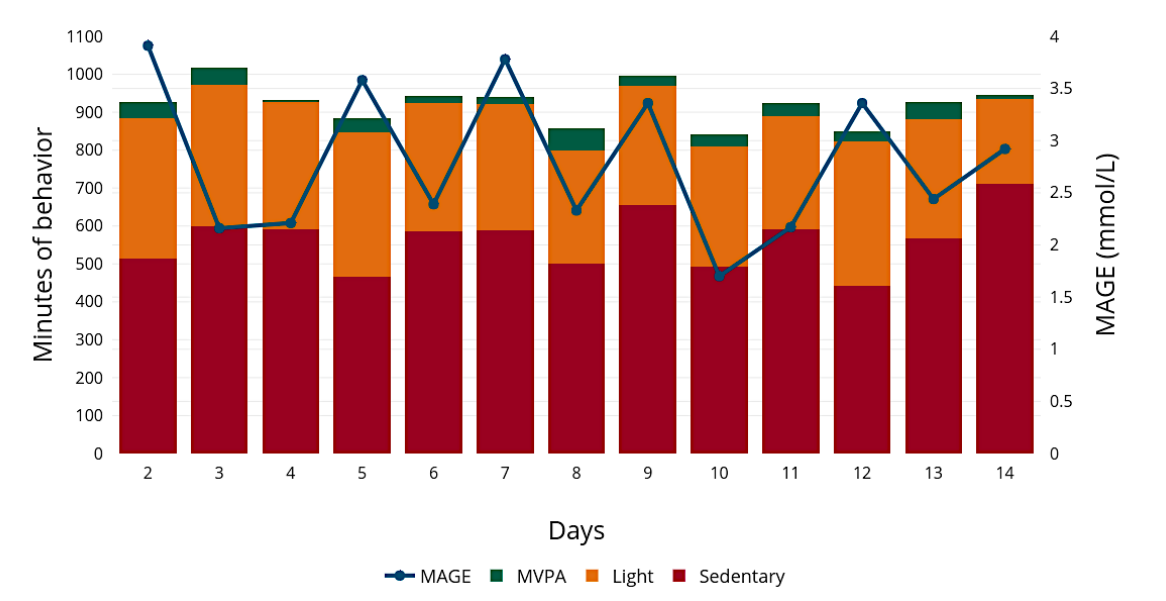
Figure 1. Minutes of sedentary, light, moderate to vigorous physical activity (MVPA) and mean amplitude of glycemic excursions (MAGE) over 13 days. Days 1 and 15 were half days and were omitted as there was insufficient data. The data represent a randomly selected female participant presenting low